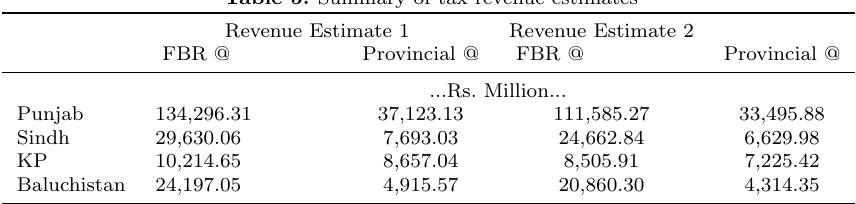
Table 5: Summary of tax revenue estimates